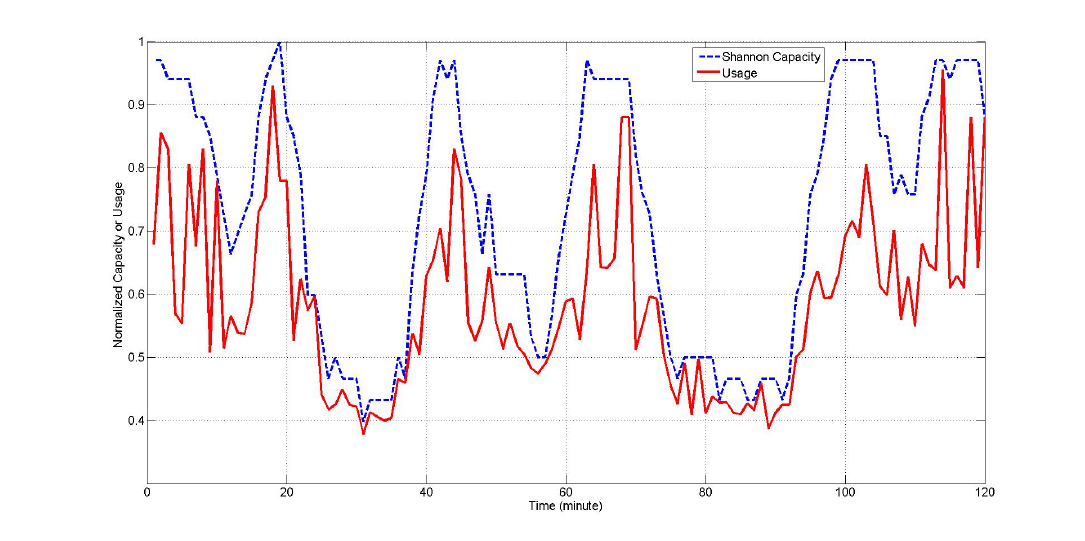
Figure 8. Comparison between normalized channel usage with channel capacity prediction based on a three-point prediction algorithm incorporating data transmission during burst traffic.